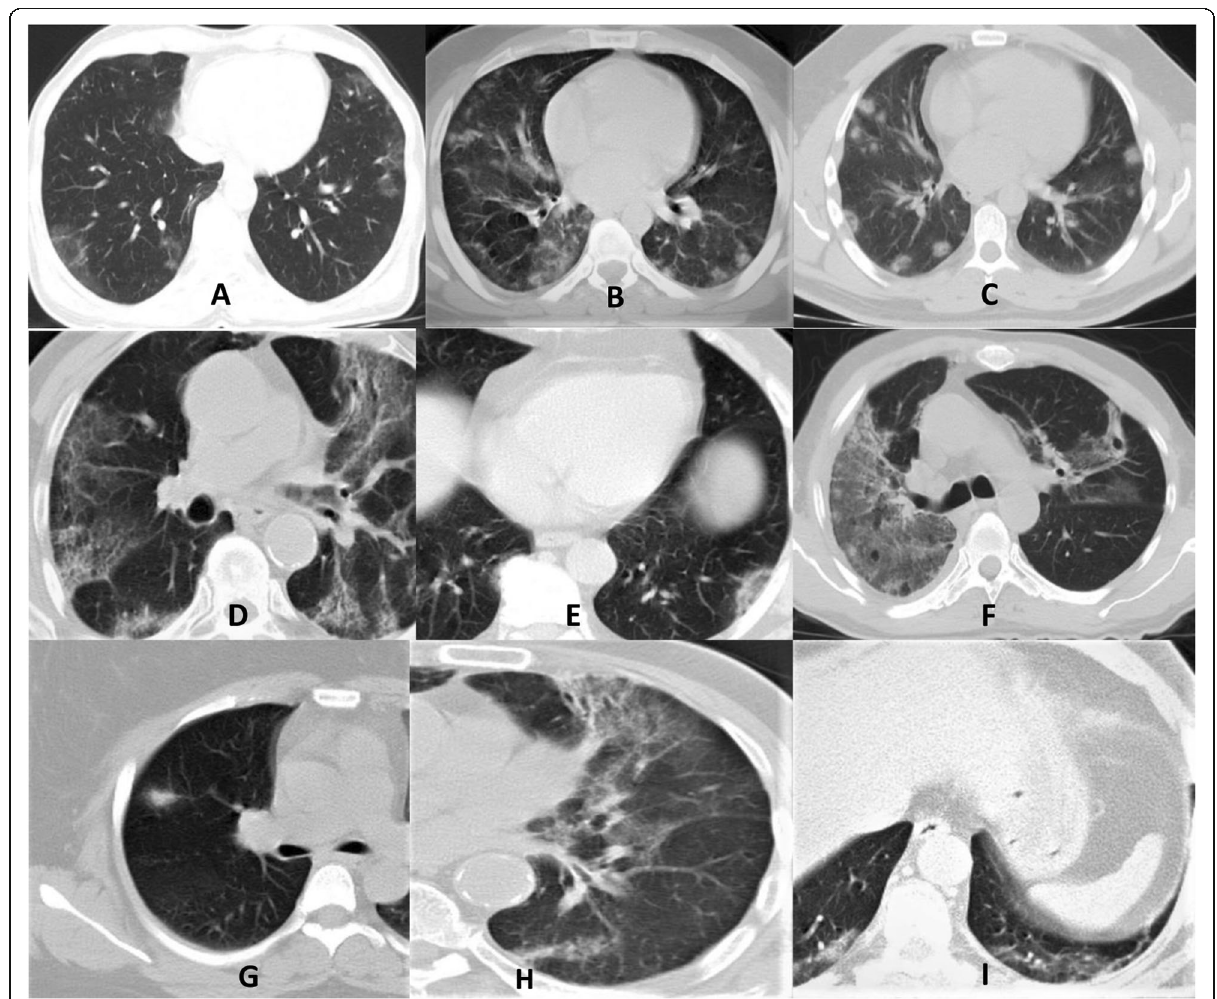
Fig. 2 Lesion patterns on CT images of RT-PCR (+) patients. a GGO, b GGO + consolidation, c Nodular consolidation, d Crazy paving, e reversed halo sign, e air bubble sign, g halo sign, h airway changes, i curvilinear